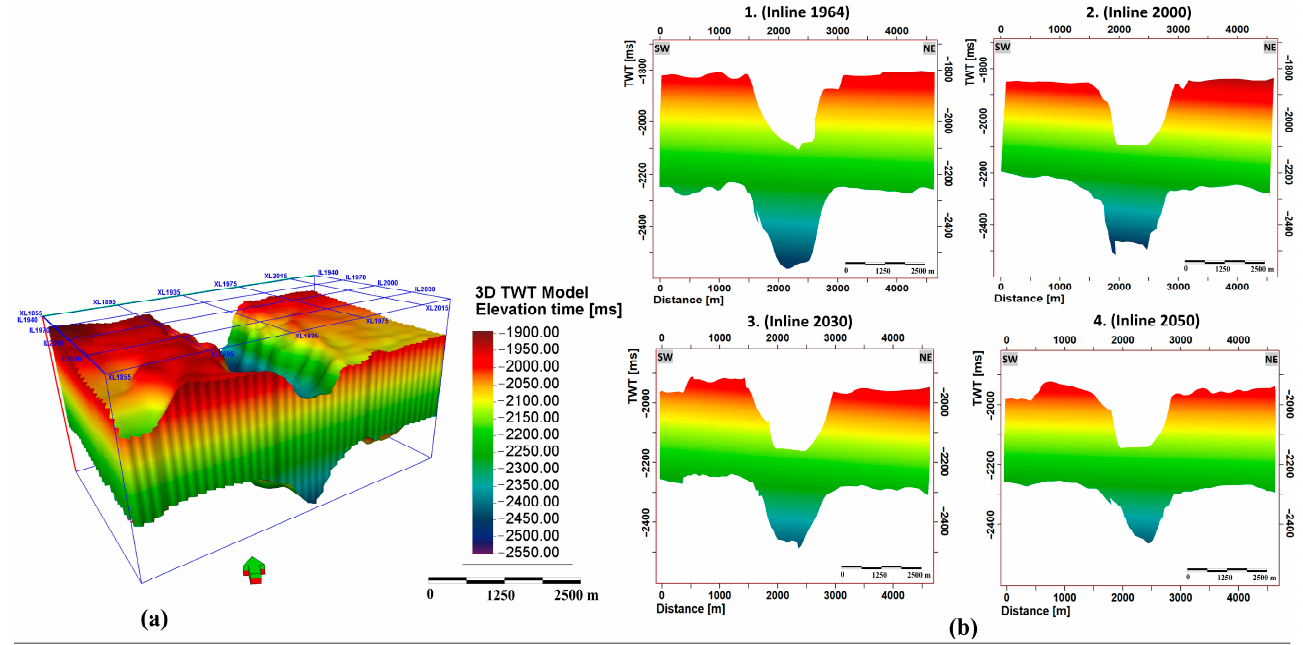
Figure 10. TWT domain structural model of the early Cretaceous stratigraphic sequence (e.g., G sand interval, E sand interval, and the Sembar Formation): ( a ) SW–SE view; ( b ) extracted inline 2D TWT cross-sections.